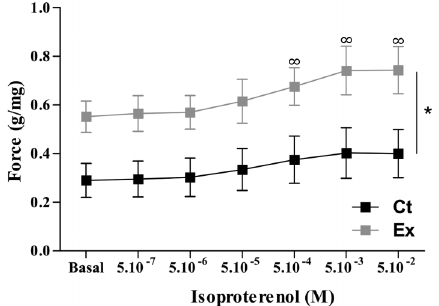
Figure 5. Effects of increasing extracellular b -agonist isoproter- enol (5.10 – 7 – 5.10 – 2 M) on force developed in isolated left ventricle papillary muscles from control (Ct, n=16) and exercised (Ex, n=16) spontaneously hypertensive rats (SHR). Results are reported as means ± SE. *P o 0.05 Ex vs Ct; N P o 0.05 vs basal and 5.10 -7 and 5.10 -6 (two-way